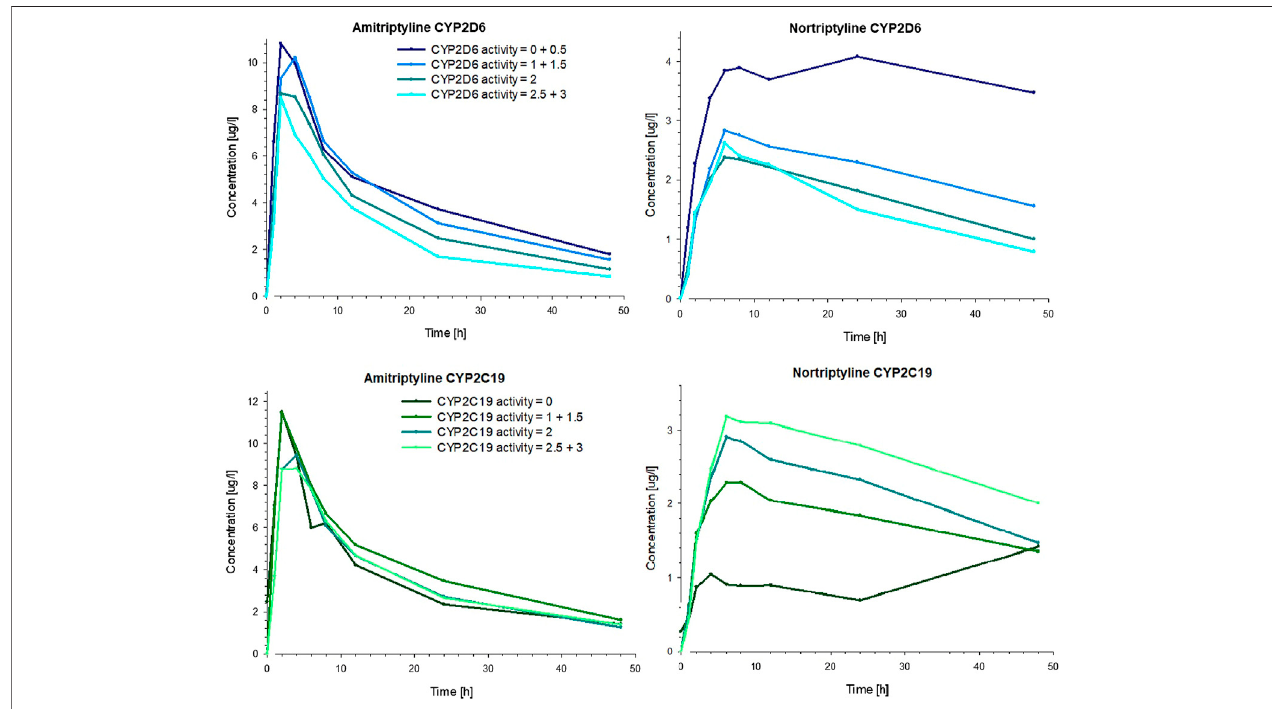
FIGURE 4 | Mean plasma concentrations ofAT (left) and NT (right) in healthy volunteers over time, strati fi ed by the number of active alleles for CYP2D6 (top) and CYP2C19 (bottom) .